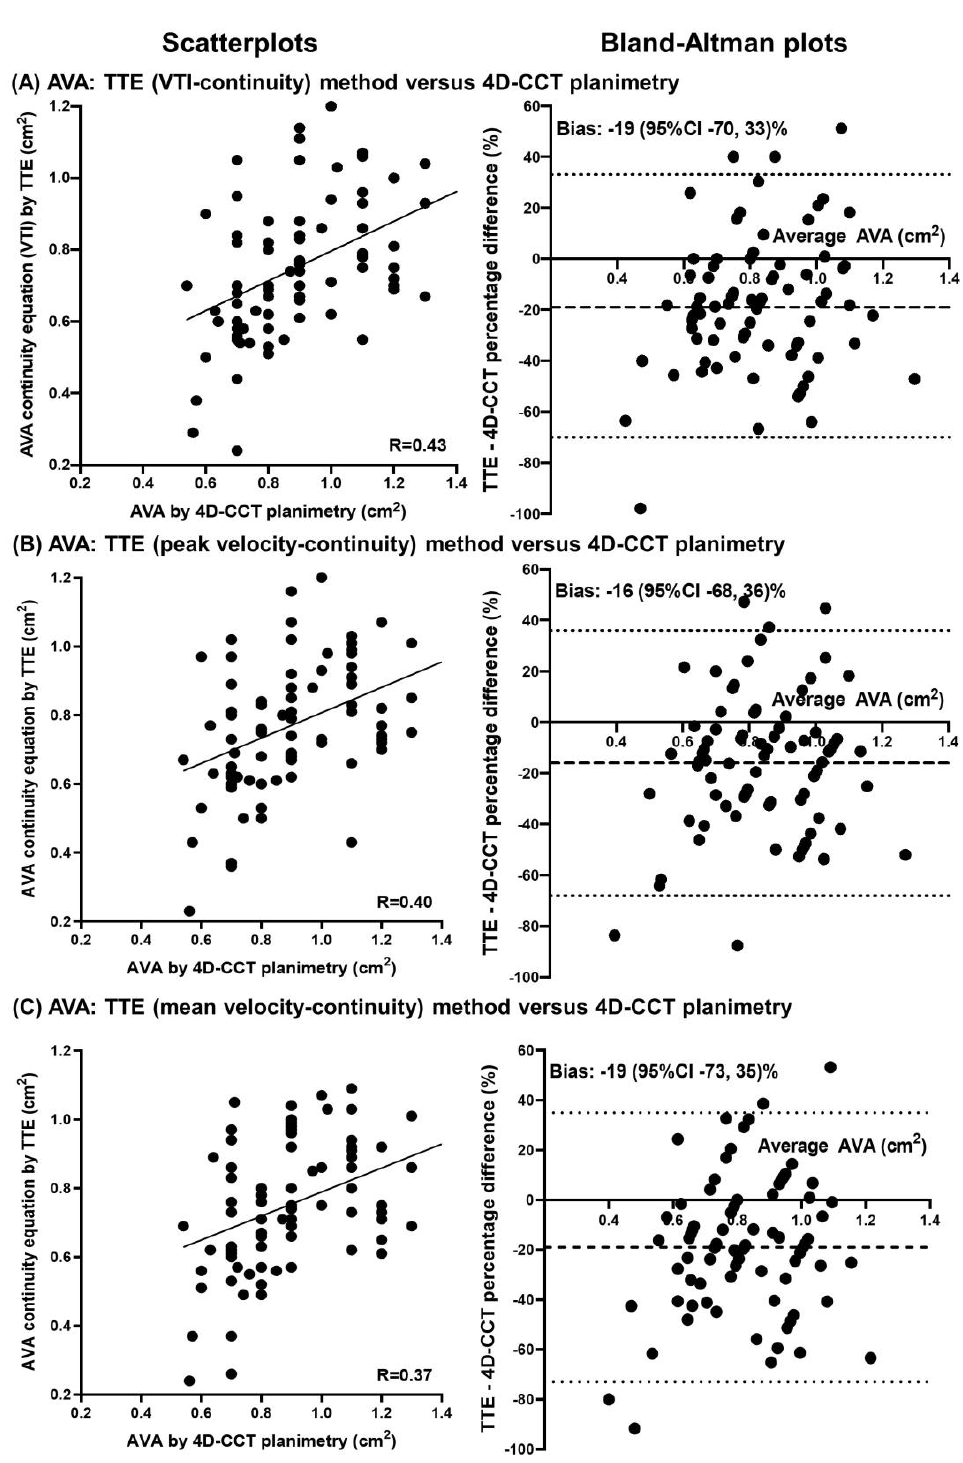
Figure 3. Comparisons between transthoracic echocardiography (TTE) and four-dimensional cardiac computed tomography (4D-CCT) estimates of aortic valve area (AVA). Scatterplots and Bland–Altman plots with Pearson correlation coefficients and percentage bias estimates with 95% confidence intervals (95% CI) comparing AVA measurements of 4D-CCT planimetry against TTE continuity equation methods using ( A ) velocity-time integrals (VTI), ( B ) peak velocities, and ( C ) mean velocities.